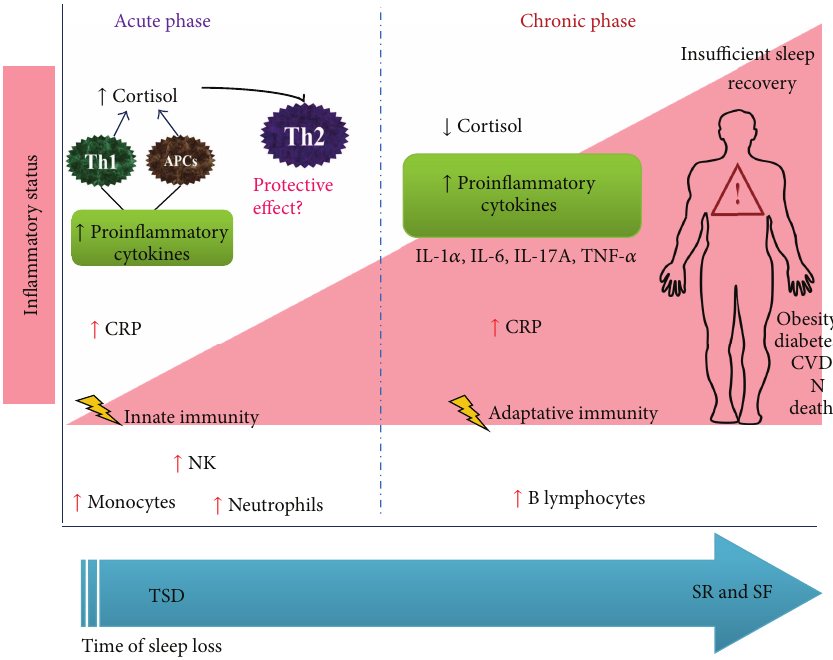
Figure 1: Sleep loss promotes a low-grade proinflammatory status. Sleep loss is characterized by an increase in circulating proinflammatory cytokines (IL-1 𝛽 , IL-6, IL-17A, TNF- 𝛼 ) and CRP. Image shows the differential effect of sleep loss on the immune system after acute total sleep deprivation and prolonged sleep restriction and or sleep fragmentation. The acute and chronic events of sleep loss correlate with the temporal immune response (innate and adaptive). Prolonged sleep loss plus insufficient sleep recovery are considered an important risk factor to develop metabolic, cardiovascular, and neurodegenerative diseases related with the deregulation of the neuro-endocrine-immune network. Abbreviations: APCs; antigen-presenting cells; CRP, C-reactive protein; CVD, cardiovascular disease; N, neurodegenerative diseases; NK, natural killer; SR, sleep restriction; SF, sleep fragmentation; TSD, total sleep